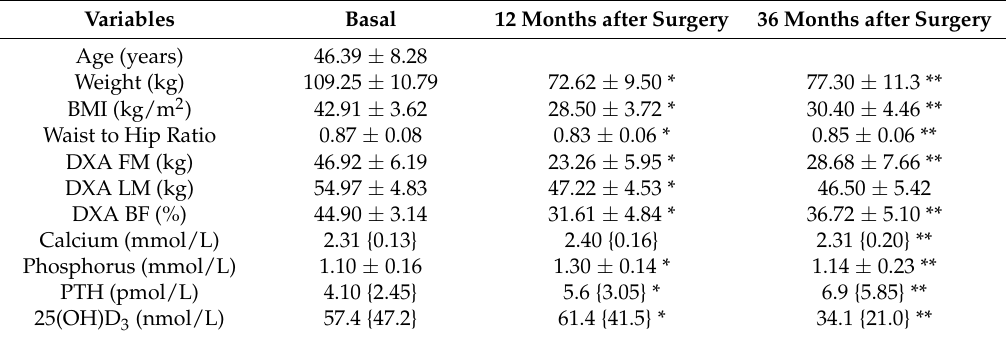
Table 1. Demographic, clinical and biochemical characteristics of study